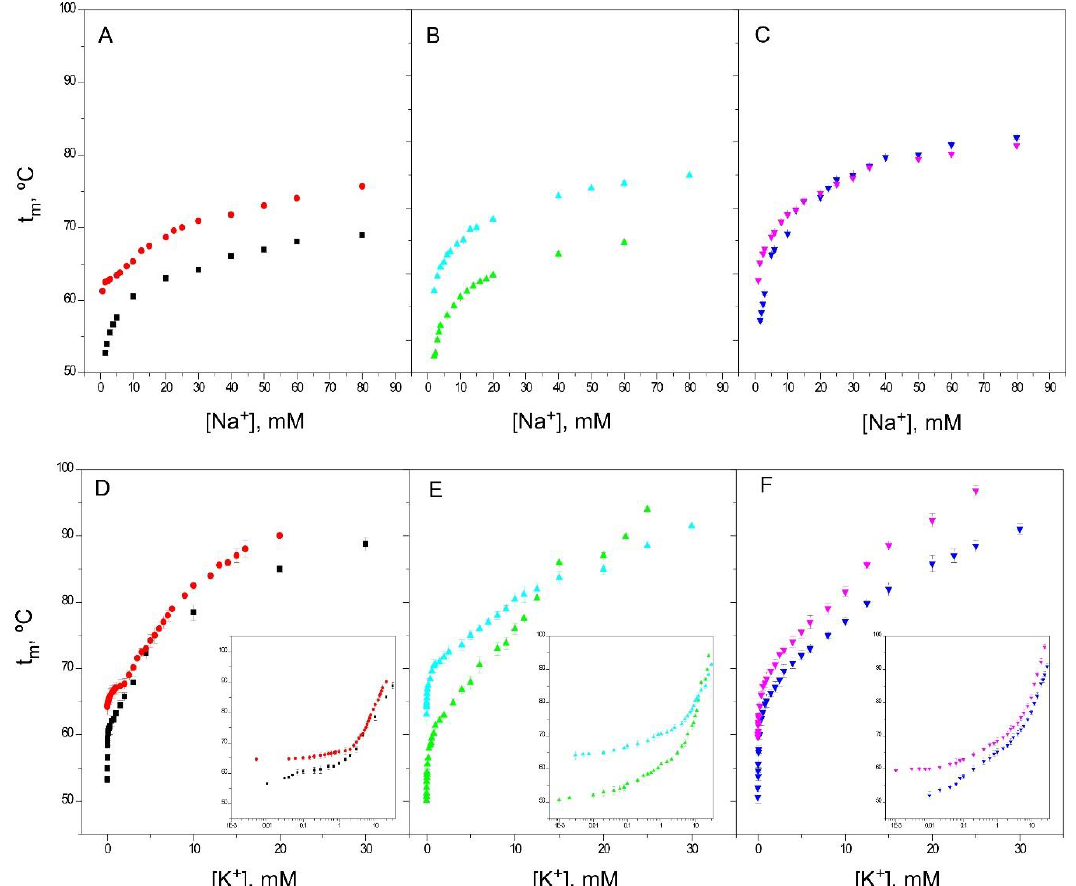
Figure 8. Effect of pH 4 on the thermal stability of the different KcsA models. Panels A , B and C compare the Na + binding profiles, while Panels D , E and F show the K + binding profiles (and the corresponding semi-log plots as insets) of the same KcsA samples prepared at pH 7 and pH 4. The results are the average ( n = 3) t m (in Celsius) ± SD. Symbols and colors are WT KcsA at pH 4 (●) and pH 7 ( ■ ); 1–125 KcsA at pH 4 ( ▲ ) and pH 7 ( ▲ ) and OPEN KcsA at pH 4 ( ▼ ) and pH 7 ( ▼ ).